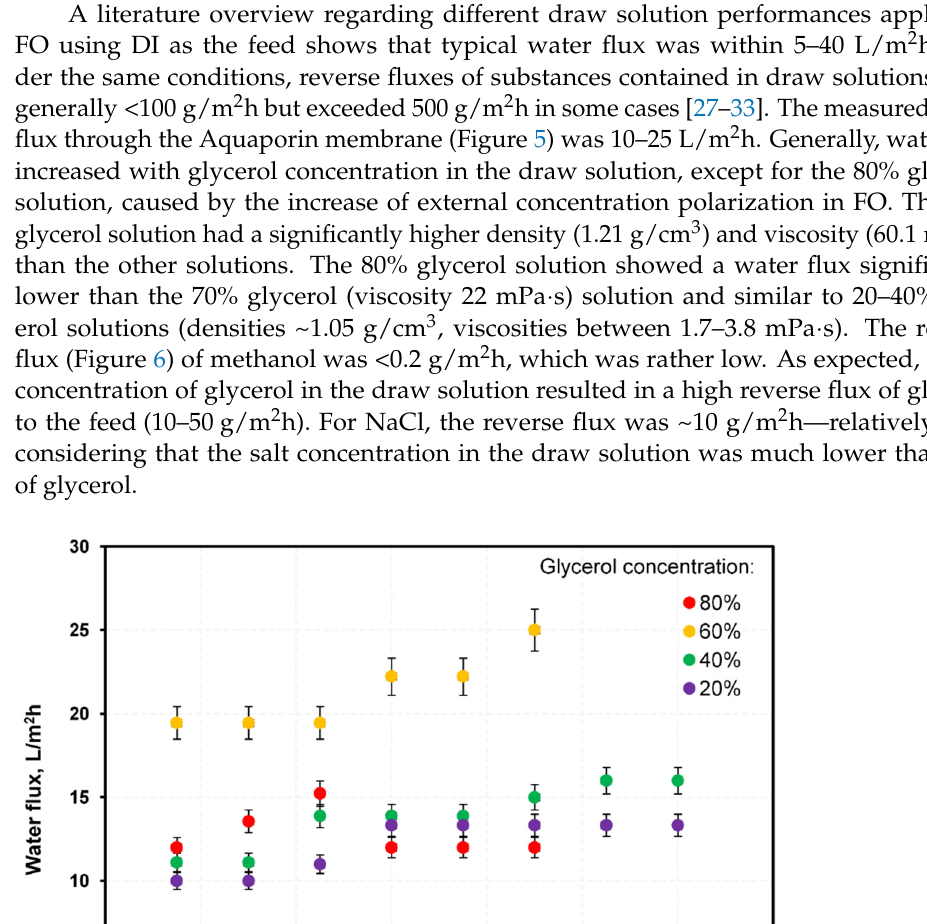
Figure 6. The measured reverse fluxes of impurities through FO Aquaporin membrane in a water– 40% glycerol–3% salt–5% methanol system. Flow mode and velocity affect hydrodynamics in boundary layers adjacent to the membrane and thus the FO effective driving force; therefore the water flux, which is the main parameter of FO processes and should be maximized. The effects of co-current or counter-current flow on water flux was investigated; the same linear flow velocity was applied to both draw and feed solutions. The observed dependence of water flux on linear flow velocity measurements for both flow modes (Figure 7) indicated that in counter-cur- rent water flux was greater in all cases. Thus, further experiments with various feed com- positions were conducted in counter-current flow mode.